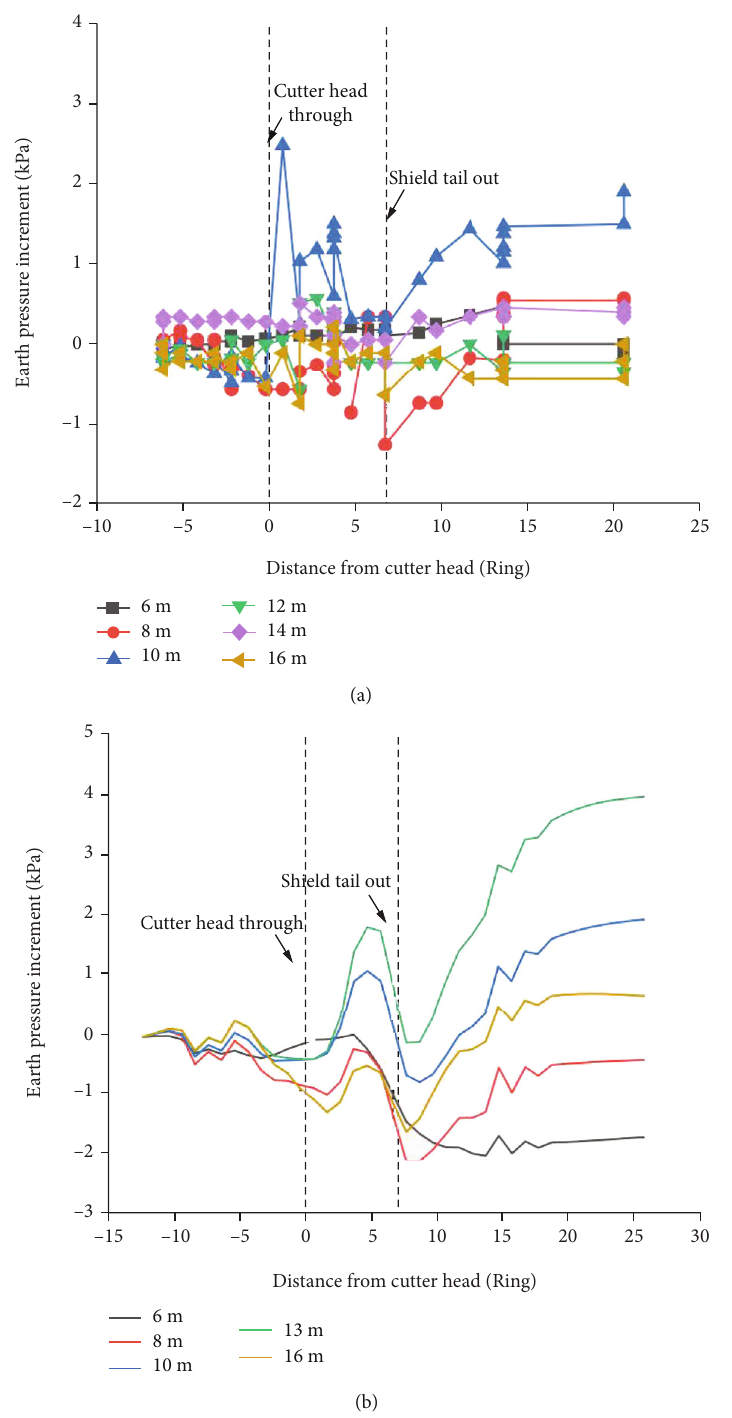
Figure 9: Time history curve of earth pressure of soil layer: (a) measured values and (b) calculation